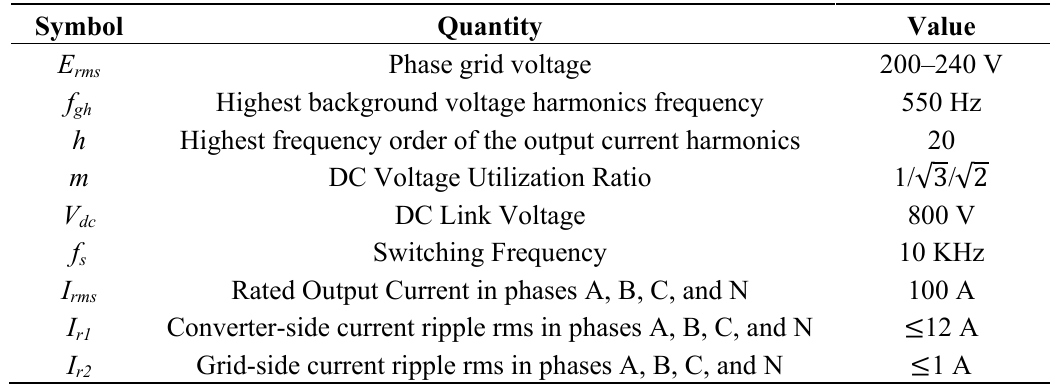
Table 1. Setup parameters.